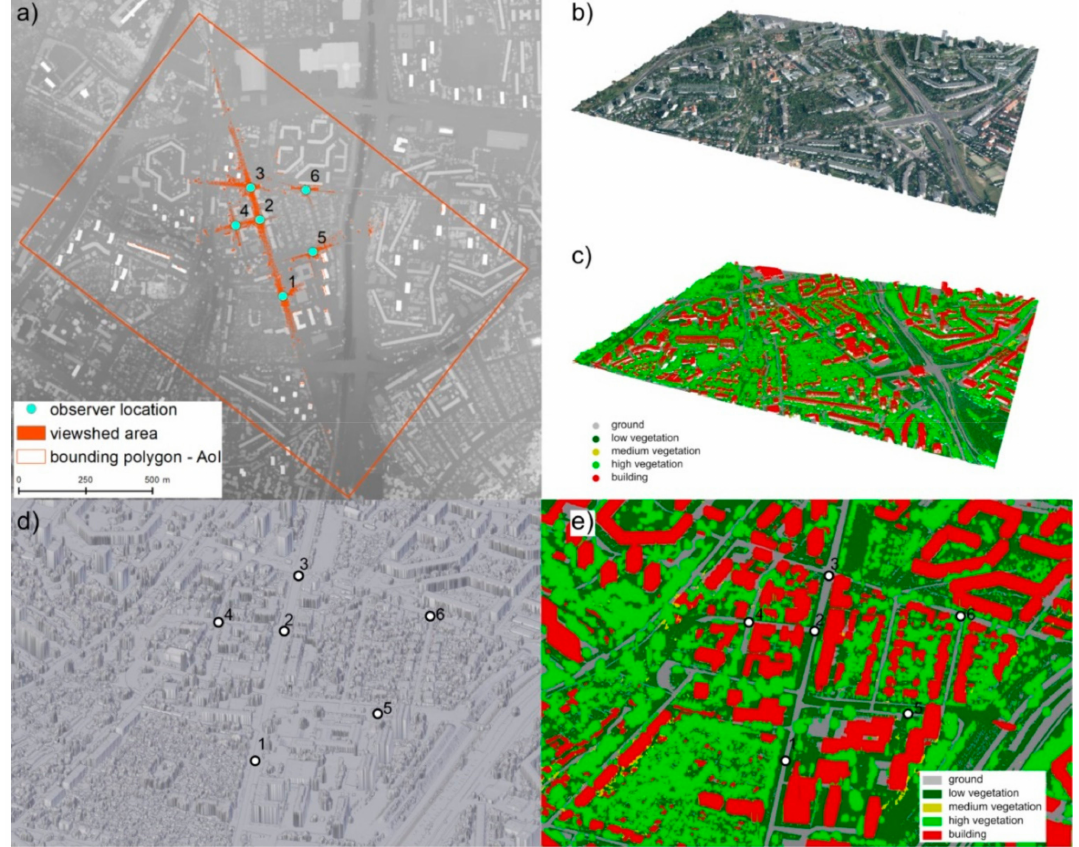
Figure 2. Study site ( a ) Digital Surface Model (DSM) and viewshed analysis results, ( b ) RGB LiDAR point cloud, ( c ) classified LiDAR point cloud, ( d ) DSM in Blender software, ( e ) Classified Digital Surface Model (CDSM) in Blender